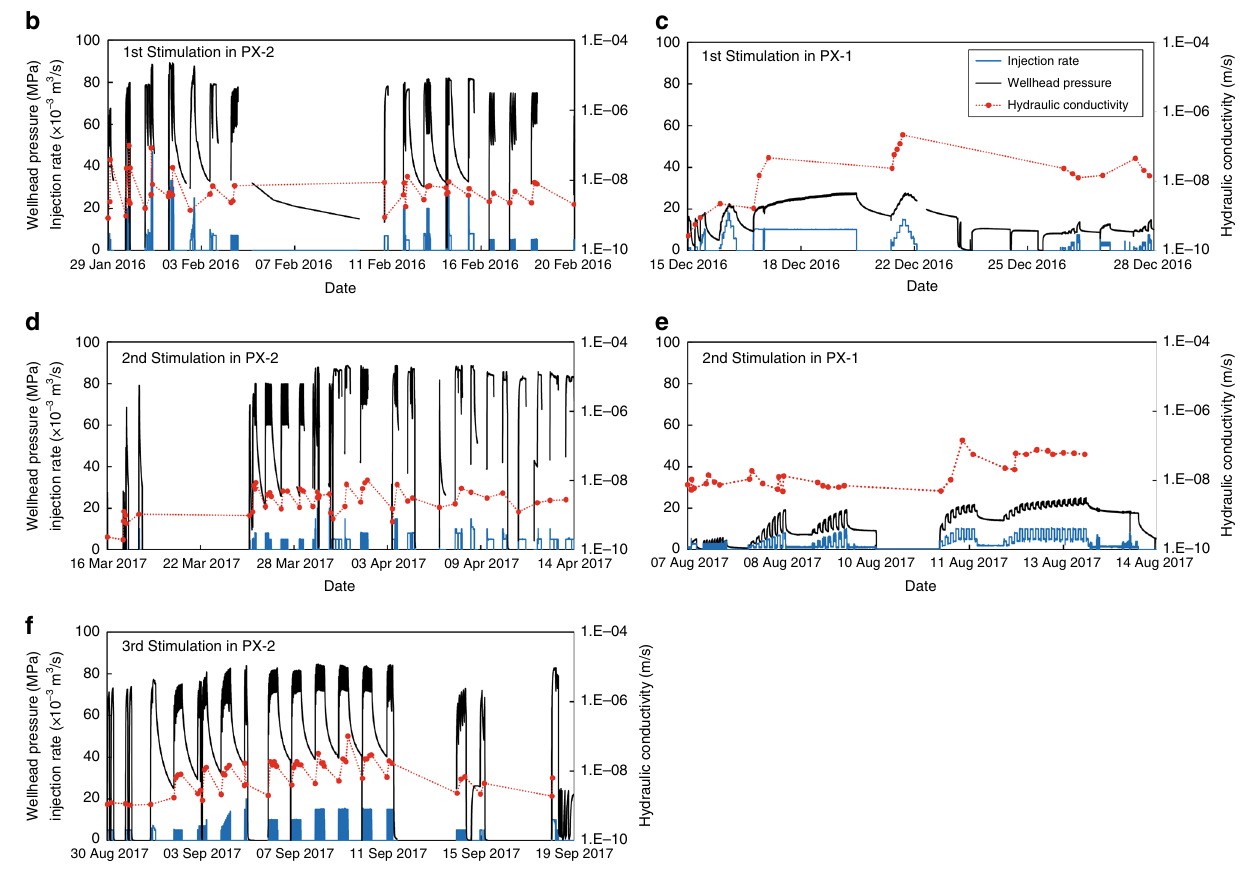
Fig. 2 Stimulation data and seismicity. a Timeline of earthquakes and fi ve hydraulic stimulations 21 : injection rate (blue), fl ow back rate (orange), and net injection volume (dark gray). The M w 3.2 event occurred during fl ow back of the third stimulation and the M w 5.5 event after the fi fth stimulation. Here, fl ow back refers to fl uids fl owing back to ground surface driven by the pressure difference between the deep rock formation near the injection interval and the ground surface. The fi rst, third, and fi fth stimulations were conducted in PX-2 and the second and fourth in PX-1. b – f Wellhead pressure (black) and injection rate (blue) measured during fi ve hydraulic stimulations, as well as hydraulic conductivity values (red) estimated by the analytical method using pressure and rate data. b , d , and f correspond to the fi rst, third, and fi fth stimulations ( fi rst, second, and third in PX-2). c and e correspond to the second and fourth stimulations ( fi rst and second in PX-1). Source data are provided as a Source Data fi